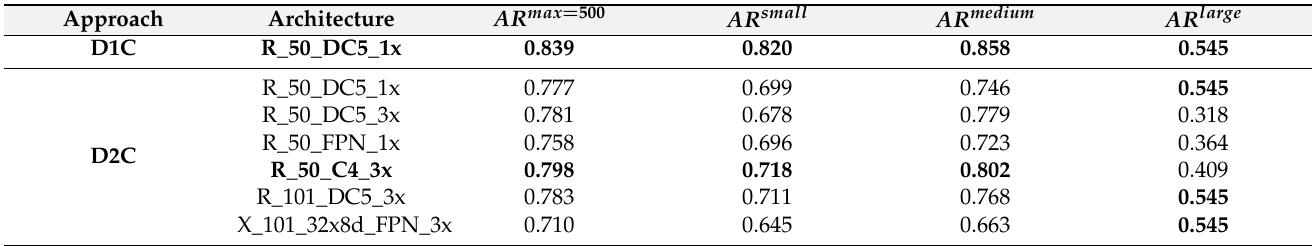
Table 4. Detection model performances based on AR . Architecture refers to the Mask R-CNN configurations available in the Detectron2 COCO-InstanceSegmentation [25].